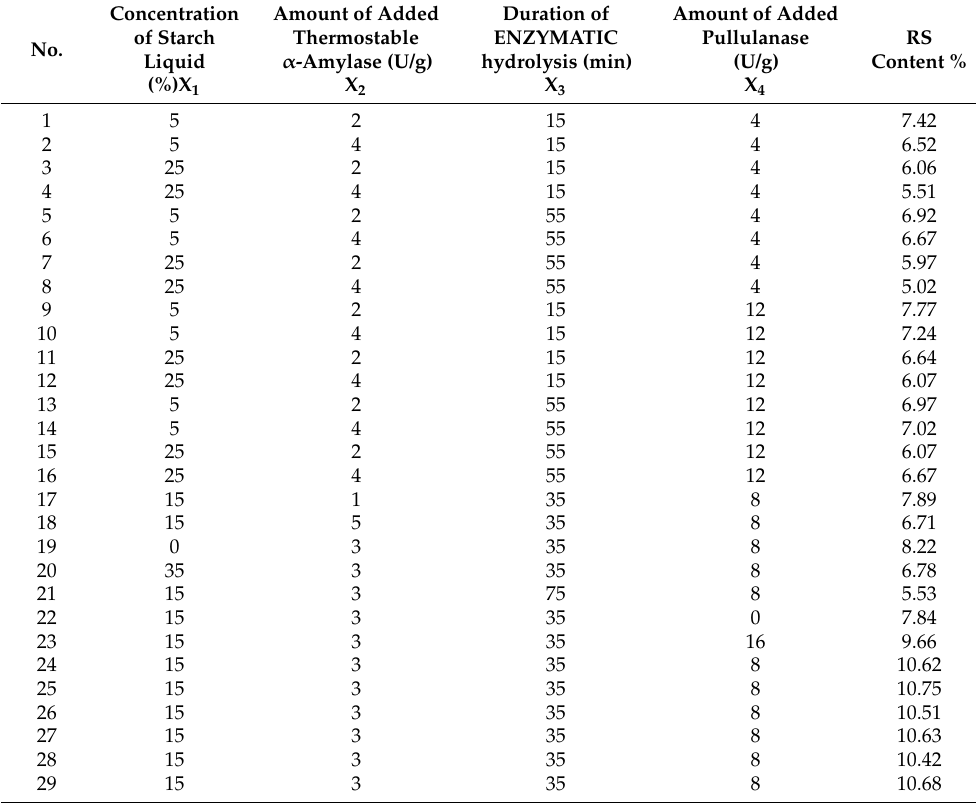
Table 2. RSM for optimization of parameters for preparation of corn starch